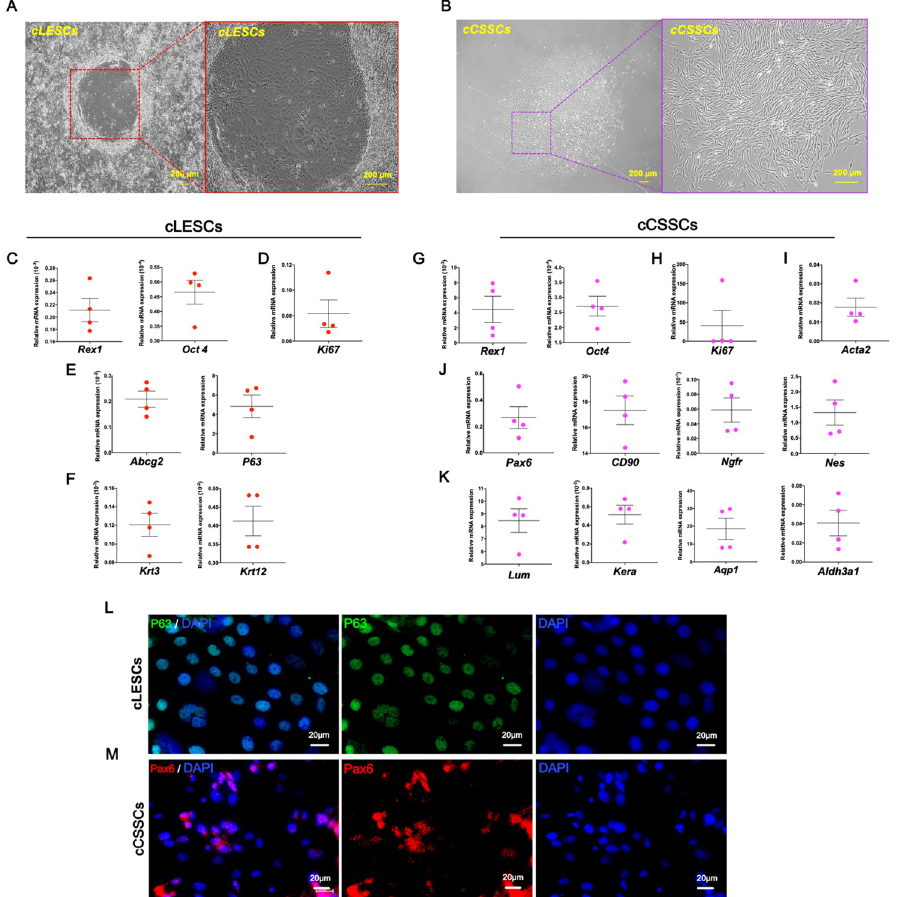
Fig 1. cLESCs and cCSSCs characterization. The morphological appearances of cLESCs (A) and cCSSCs (B) are illustrated under a phase contrast microscope with 40x and 100x magnification. cLESCs and cCSSCs mRNA expression are quantified by RT-qPCR and normalized by Gapdh . Pluripotent stemness-related markers (C, G), adult stemness-related markers (E, J), proliferation marker (D, H), myofibroblast marker (I), epithelial cell markers (F), keratocyte marker (K) are characterized (n = 4). Immunocytochemistry of cLESCs and cCSSCs expresses P63 and Pax6 respectively (L, M) with 400x magnification. The scale bars present 200 μ m (A, B) and 20 (L, M).